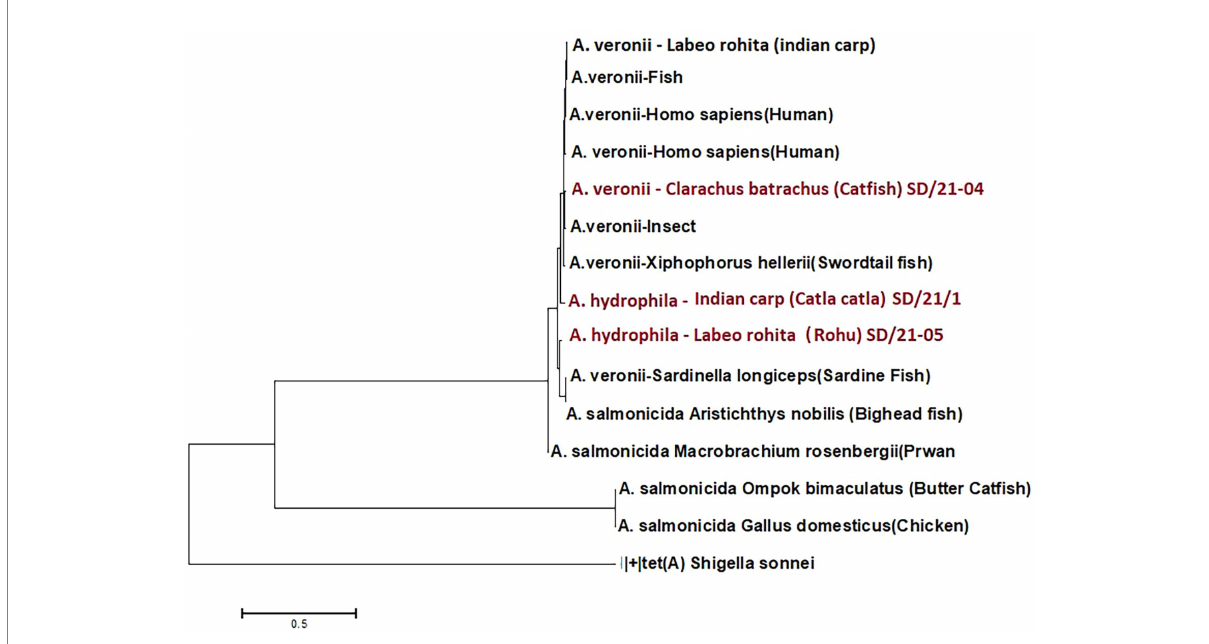
FIGURE 2 Phylogenetic analysis of Ambler class B metallo- β -lactam (MBL) resistance genes from 13 Aeromonas spp. isolated from different host species in India.